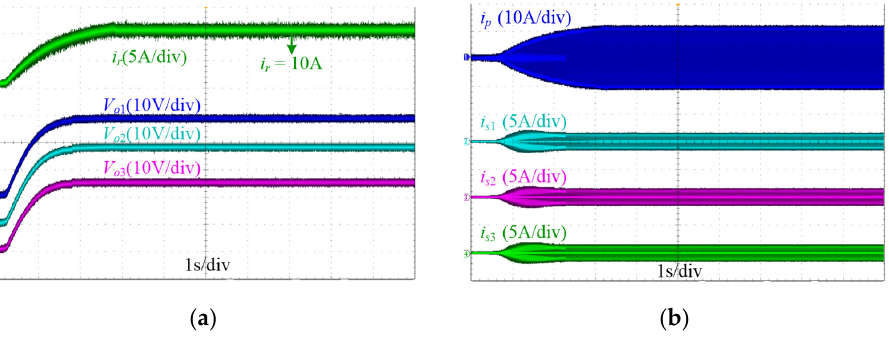
Figure 12. Startup waveforms under balanced load conditions. ( a ) Waveforms of the current source converter and the output modules. ( b ) Waveforms of the primary and secondary current.